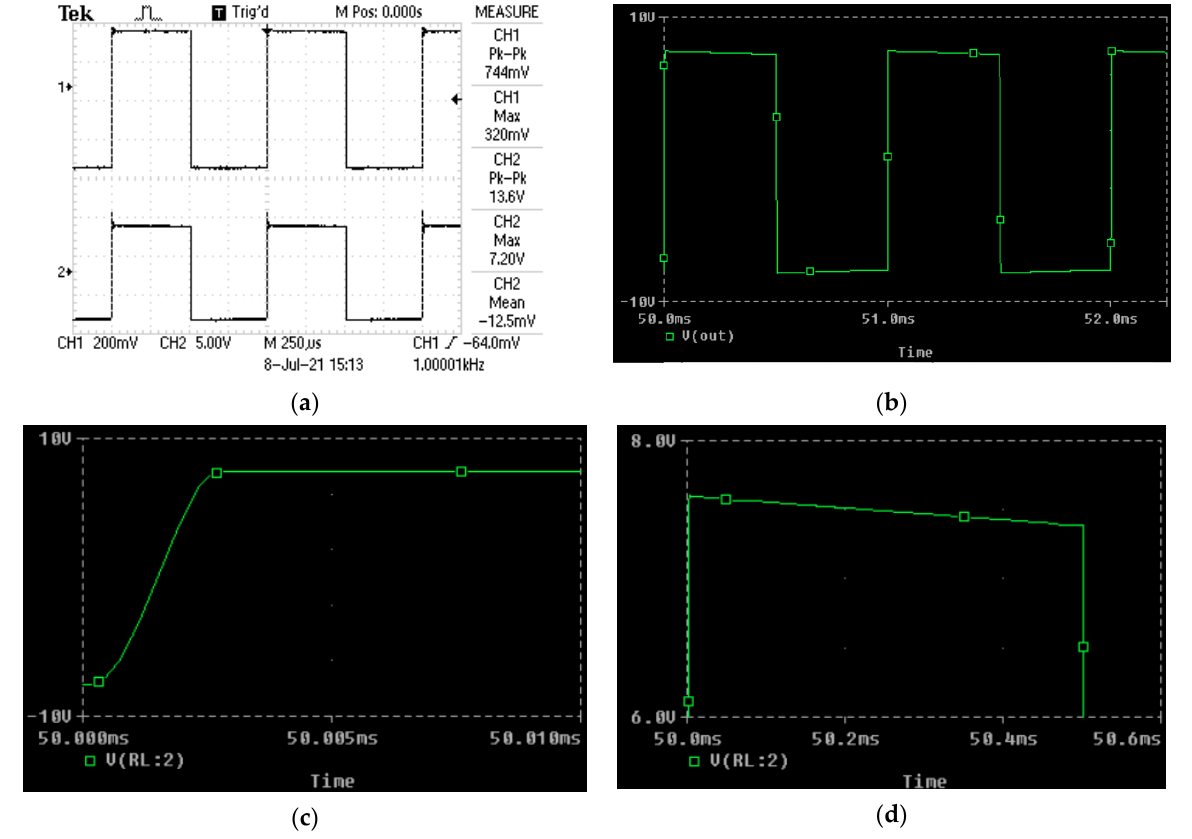
Figure 14. Large-signal transient response for the non-inverting amplifier in Figure 12: ( a ) measured results of the real device at a load resistance equal to 8 Ω ; ( b ) simulated results of the proposed macro-model at a load resistance equal to 8 Ω ; ( c ) simulated results for the positive slew rate at 8 Ω ; ( d ) simulated results for the voltage drop of the part of the output signal at 8 Ω .